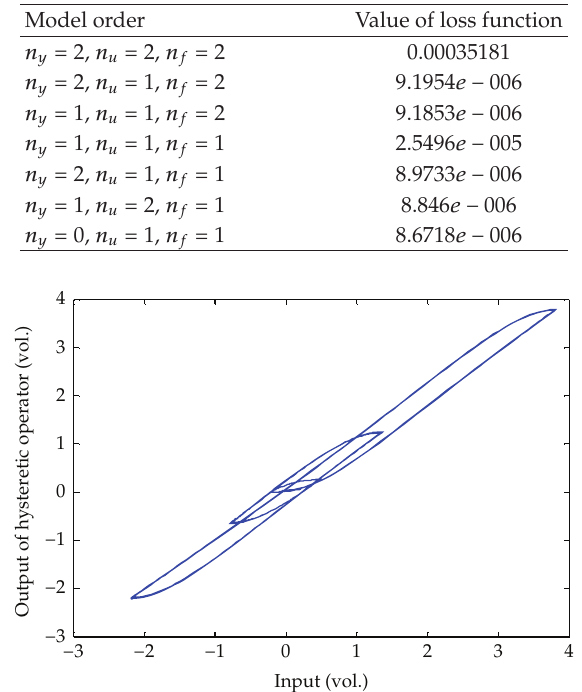
Figure 3: The input-output plot of the hysteretic operator used in expanded input